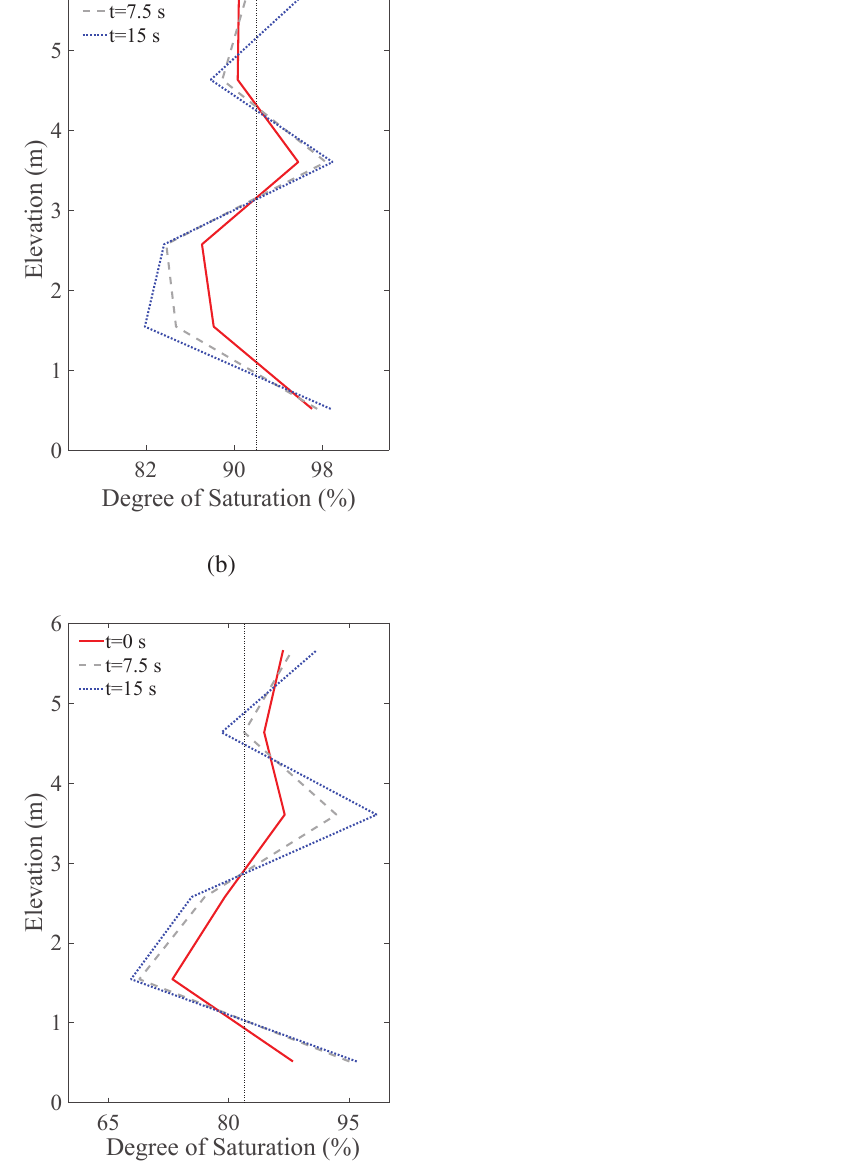
Figure 14. Degree of saturation at different elevations for desaturated soil deposits during the shaking ( a ) S = 92% and ( b ) S =